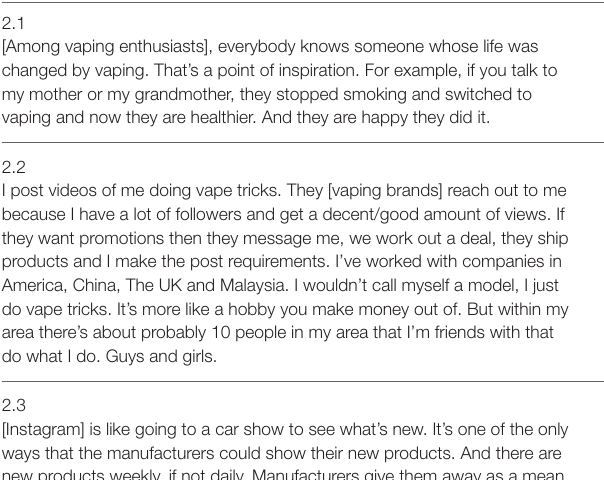
TABLE 3 | Quotes from focus groups with 18 to 25-year-old Berkeley residents ( N = 8).